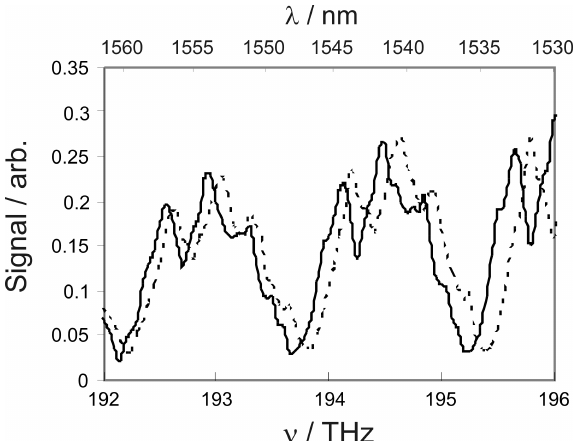
Figure 7. Frequency shift on binding of streptavidin to a biotinylated fibre. The spectrum of the biotinylated fibre is shown before and after the introduction of streptavidin to the sample cell as the dashed and solid lines,